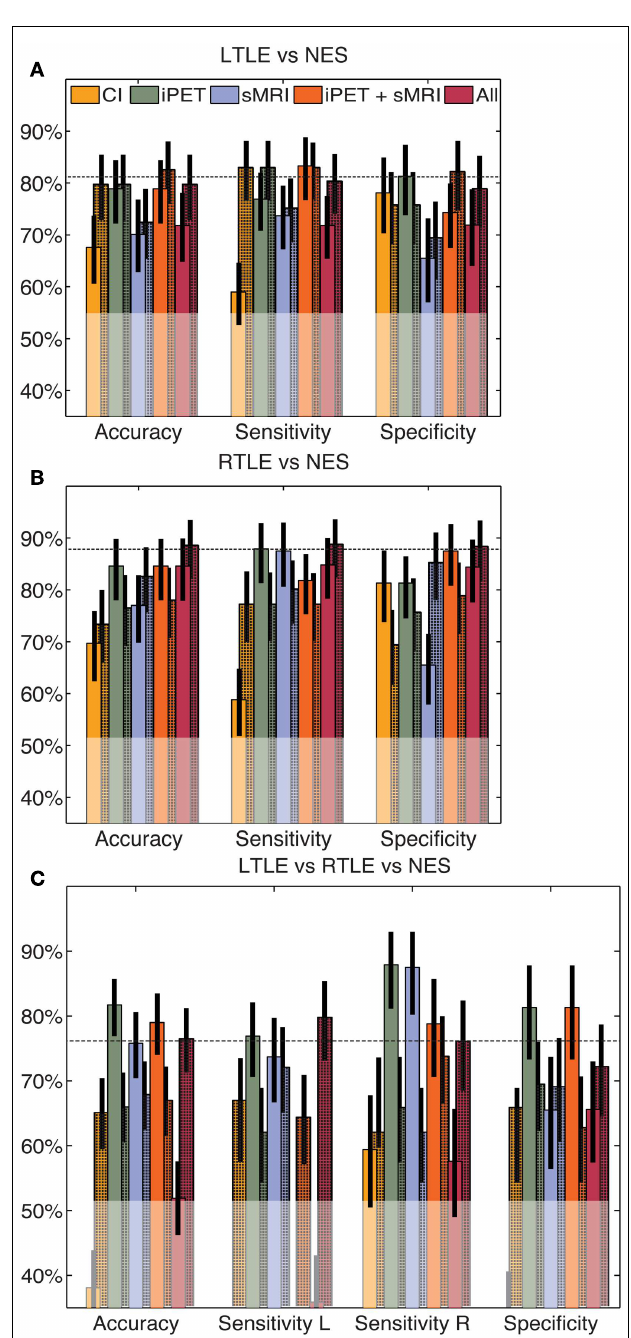
FIGURE 3 |Automated combination of clinical information with automated analysis of iPET images. The automated combination of clinical information and/or MA with our analysis produced no significant change in performance for the LTLE (A) , RTLE (B) or trinary (C) classifiers, relative to the CAD operating on automated values alone.The unshaded bars indicate the performance of similarly constructed CAD tools using clinical information or the results of MA alone.The shaded bars indicate the modified performance when information from NeuroQ is added.The horizontal line indicates the mean accuracy of each CAD tool without clinical information.The translucent region indicates the performance of a naïve